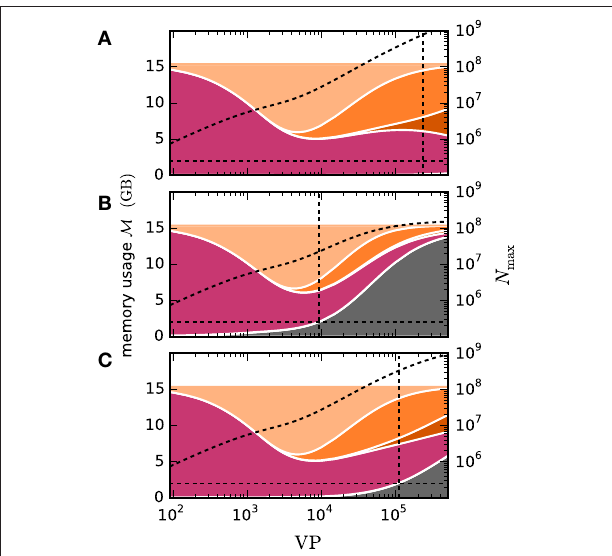
FIGURE 14 | Predicted cumulative memory usage as a function of number of virtual processes for a maximum-filling scaling. Contributions of different data structure components to total memory usage M of NEST for Test case 3 with a network size that just fits on VP cores of JUQUEEN. The dashed black curves indicate the corresponding network size N max . Contributions of synapse objects and relevant components of connection infrastructure are shown in pink and shades of orange, respectively. The contribution of the base memory usage, particularly containing the receive buffer, are marked in gray. Other contributions as the neuron objects, and neuron infrastructure are significantly smaller and hence not visible at this scale. Dark orange: sparse table, orange: intermediate infrastructure containing exactly 1 synapse, light orange: intermediate infrastructure containing more than 1 synapse. The cumulative memory usage is calculated using the memory-consumption model of Kunkel et al. (2014). The horizontal dashed black line indicates 2 GB limit of a single MPI communication. Vertical lines indicate the largest number of virtual processes possible, due to full JUQUEEN, respectively exceeding a 2GB communication buffer. (A) Test case 3 without gap junctions (B) Test case 3 with additional gap junctions between inhibitory neurons ( 60 gap junctions per neuron). The communication is carried out in intervals of the minimal delay ( d min = 1 . 5ms and h = 0 . 1ms ) (C) Same setup as (B) with communication in every time